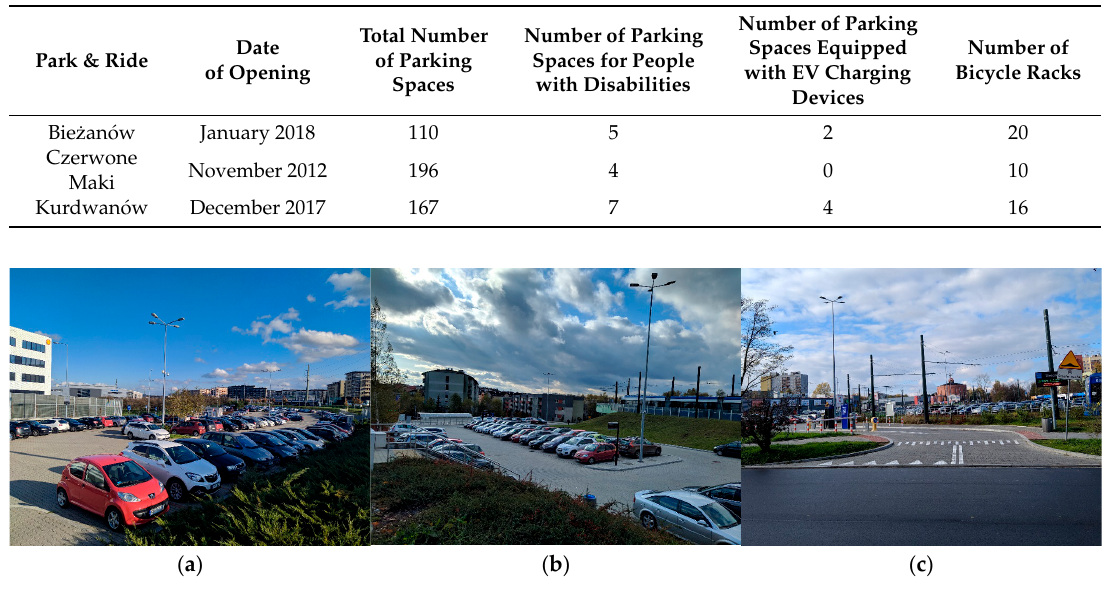
Table 1. General characteristics of the analyzed P&R parking in Cracow. Source: Own research based on [55].